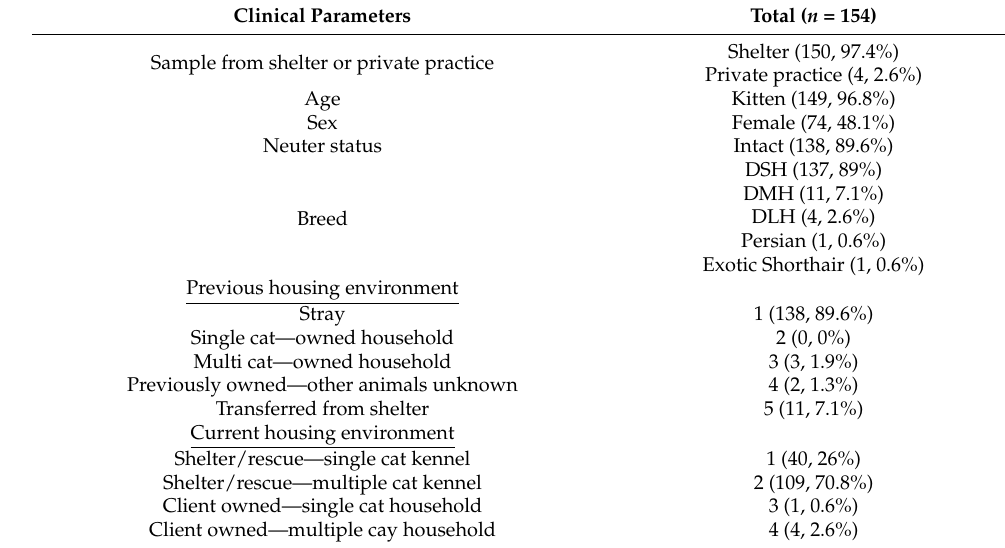
Table 3. Summary of clinical presentation data for Microsporum canis positive